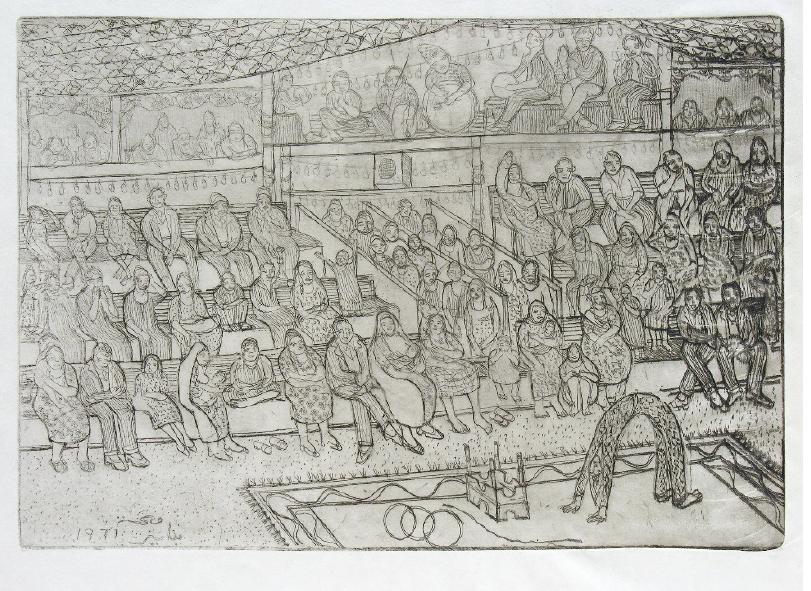
Figure 16. Menhat Helmy, Circus or Popular Theatre, 1961 etching. Courtesy of estate of Menhat Helmy. See also, reprint in 1963 Ljubljana Biennale